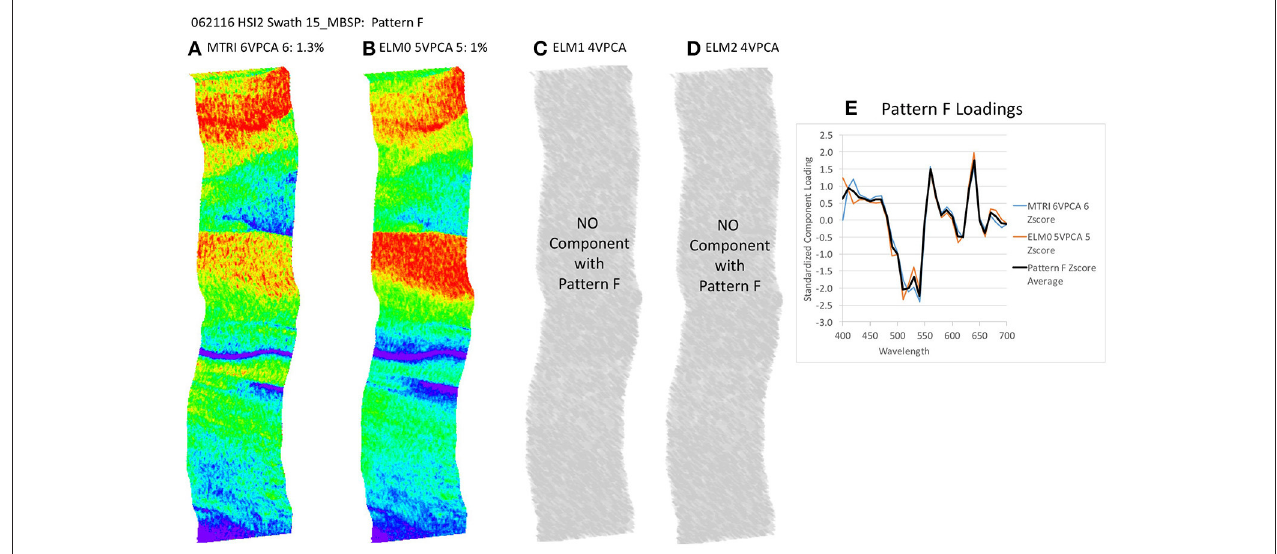
FIGURE 13 | Spatial distribution of varimax-rotated principal component analysis (VPCA) component pattern F. (A) Michigan Tech Research Institute (MTRI) correction method decomposition. (B) Empirical Line Method 0 (ELM0) correction method decomposition. (C) Empirical Line Method 1 (ELM1) correction method